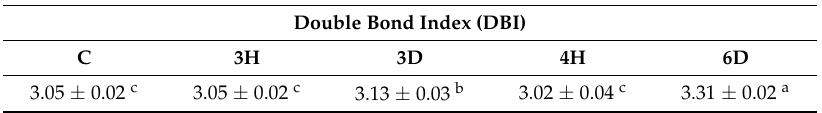
Table 1. Changes in the double bond index (DBI) for the total polar lipids in the A. thaliana seeds during the hydration–dehydration cycles.